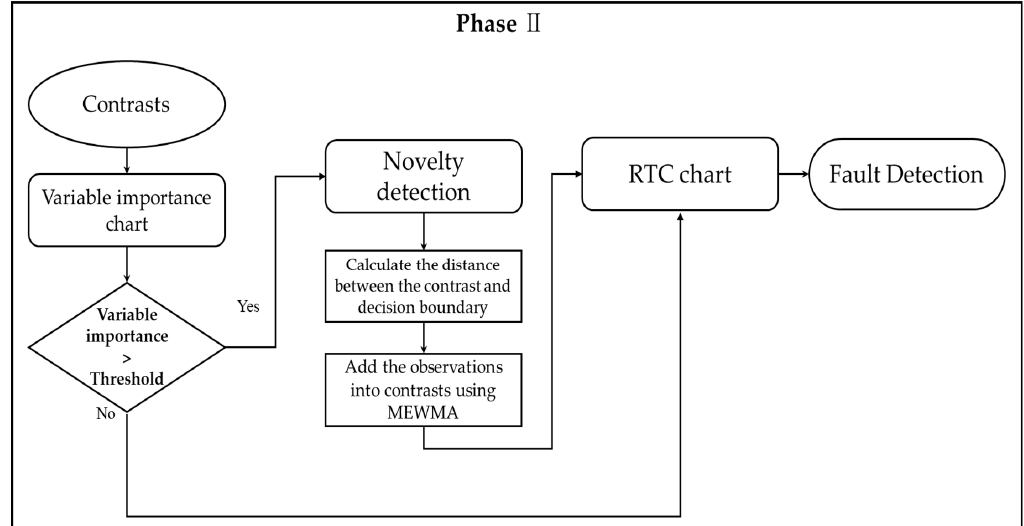
Figure 3. Phase II of the proposed method. MEWMA: multivariate exponentially weighted moving average.